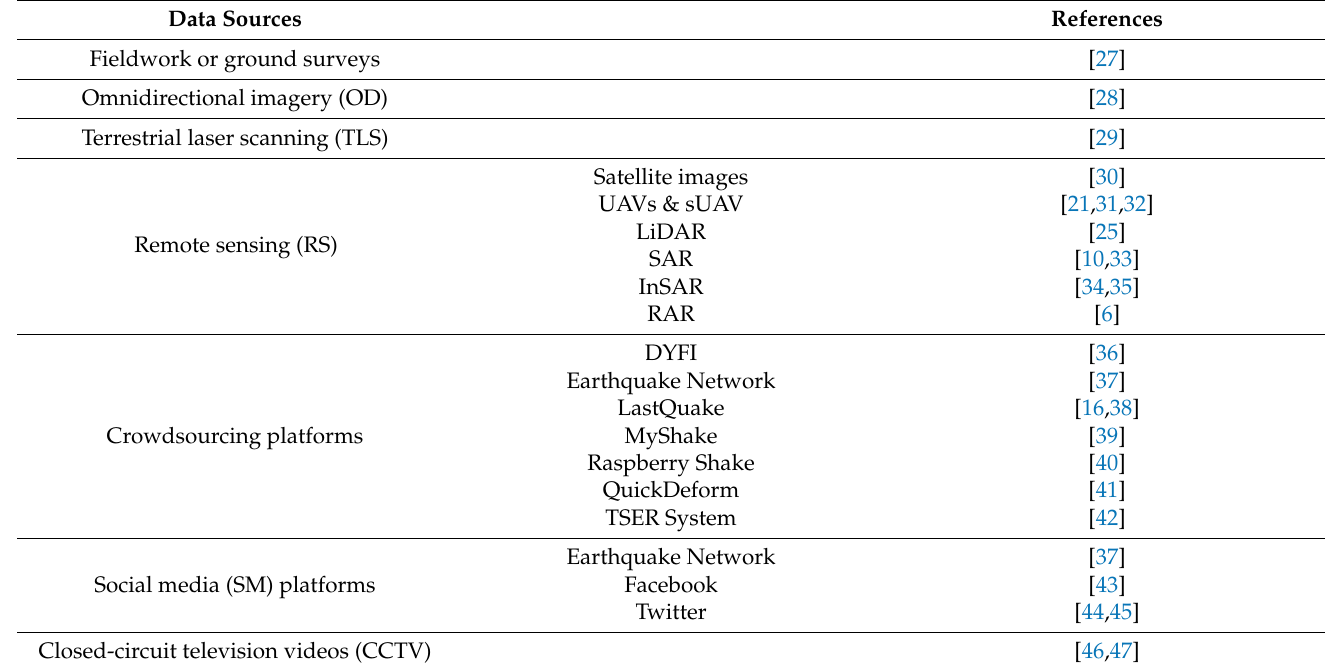
Table 1. Summary of references reviewed for this literature review.